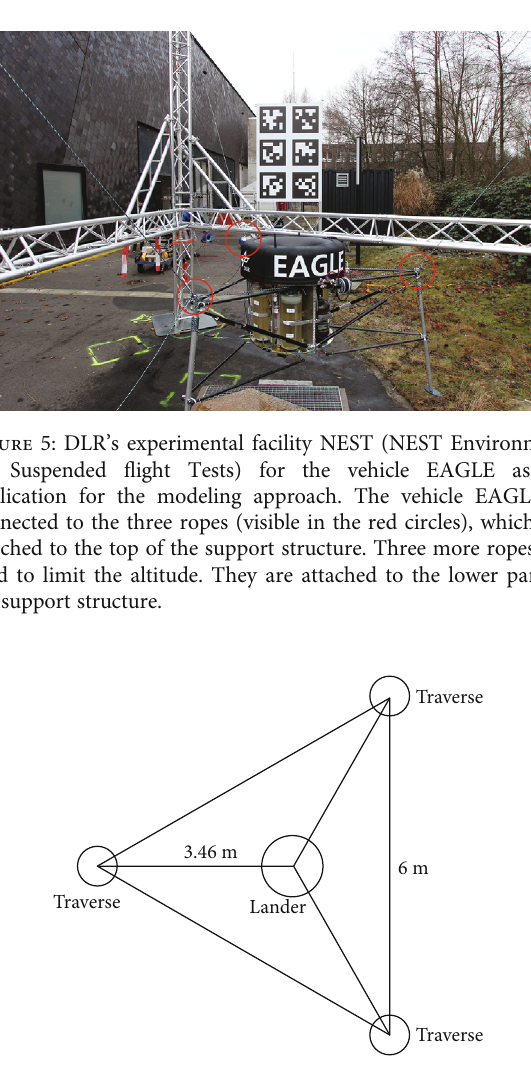
Figure 6: Top view on NEST experimental setup. The traverse poles are arranged as a triangle with a distance of 6 m. The lander is fi xed with three tethers which are led over turning wheels at the top part of a traverse pole to the bottom inside the pole. Here, the lander rests at the middle of the triangle.